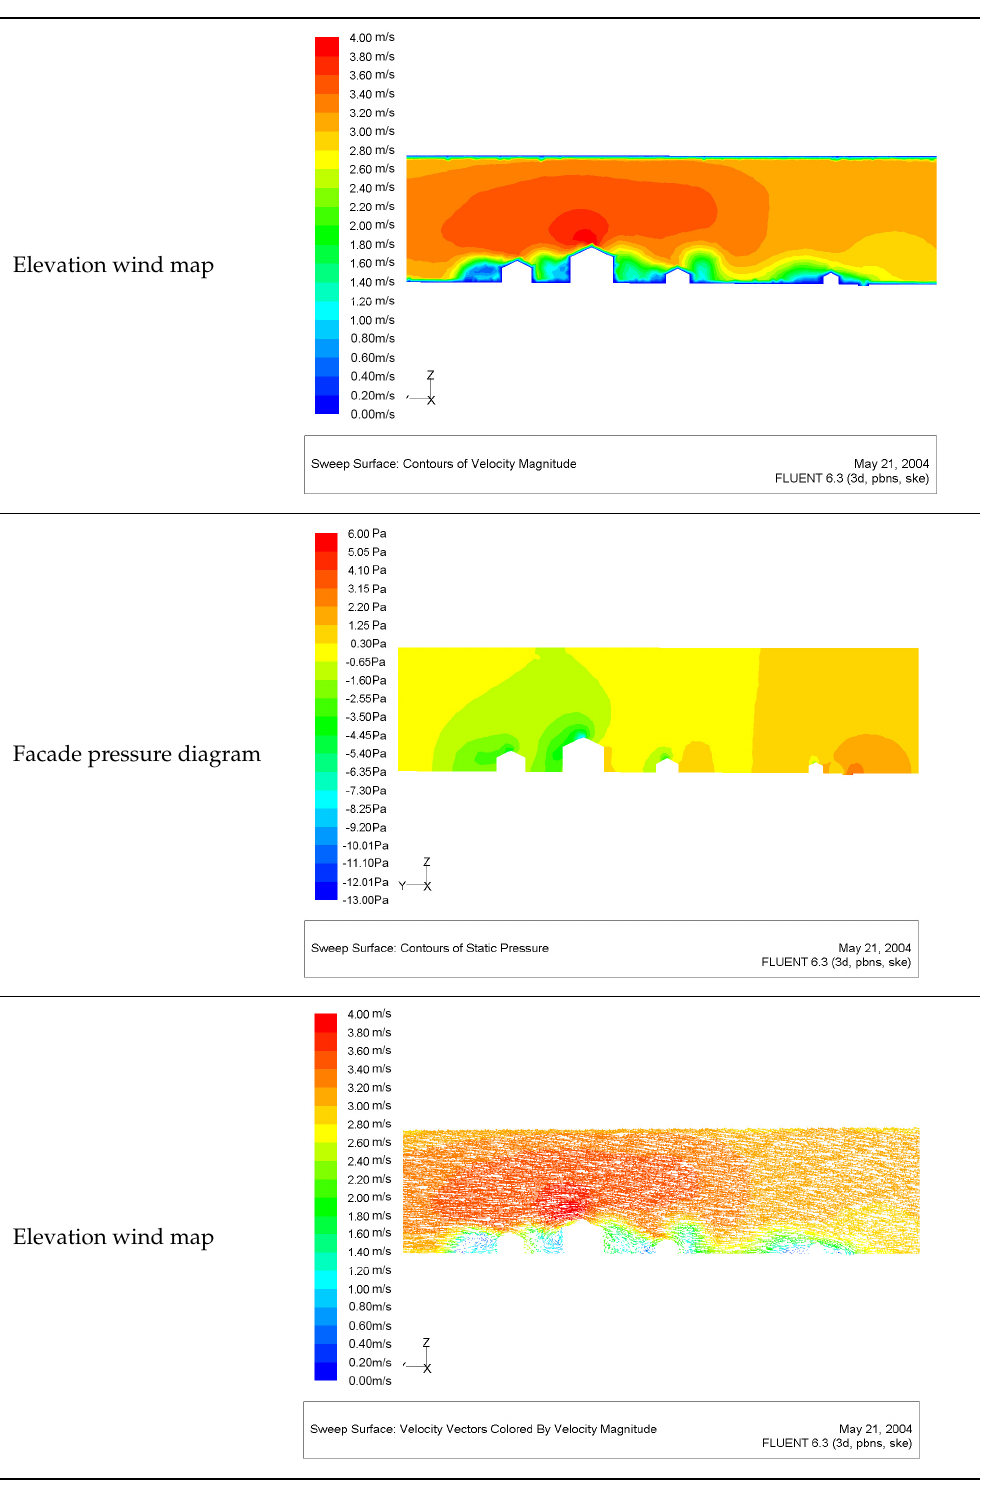
Table 3. Three-dimensional wind pressure and direction maps (the picture above shows the situa- tion before the